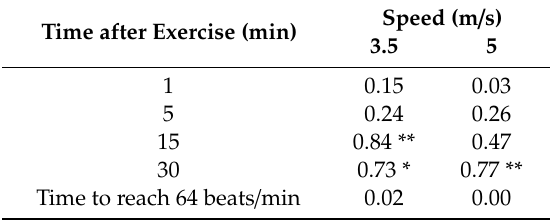
Table 6. Coe ffi cient of determination (r 2 ) and level of significance of the relationship between resting heart rate and recovery heart rate after 60 min of exercise at 3.5 m / s and 5 m / s (seven horses). Speed (m / Time after Exercise (min)